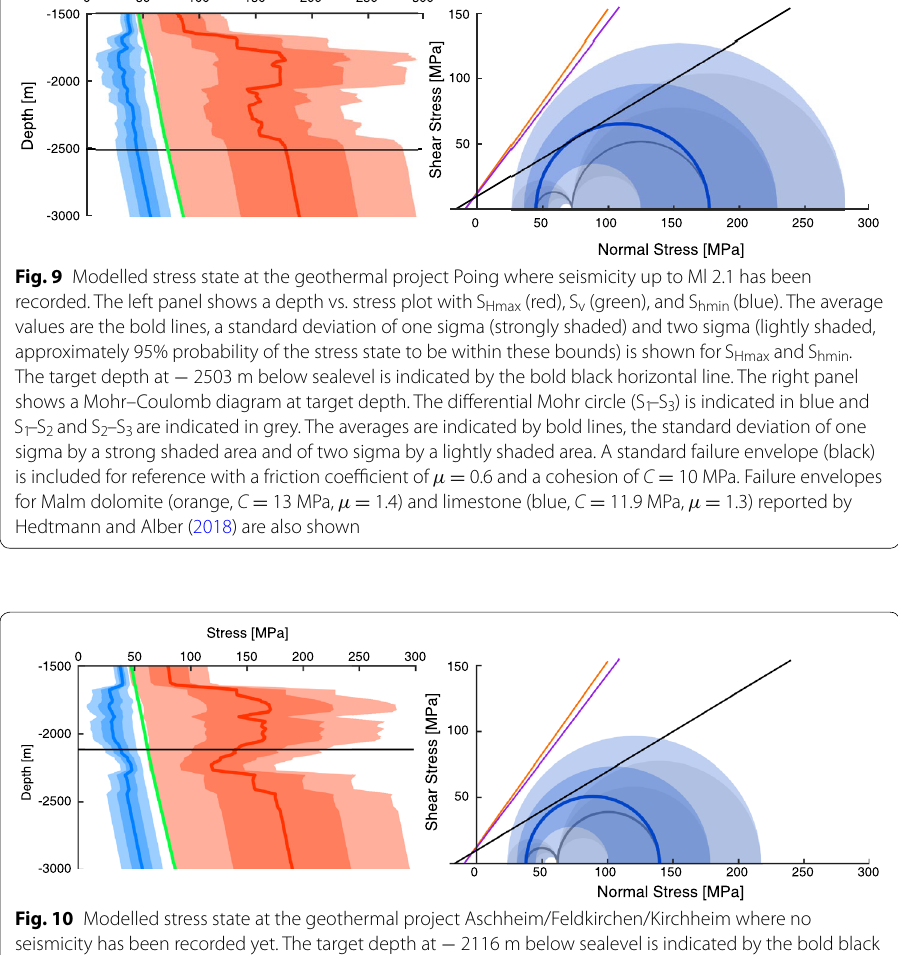
2116 m below sealevel is indicated by the bold black −